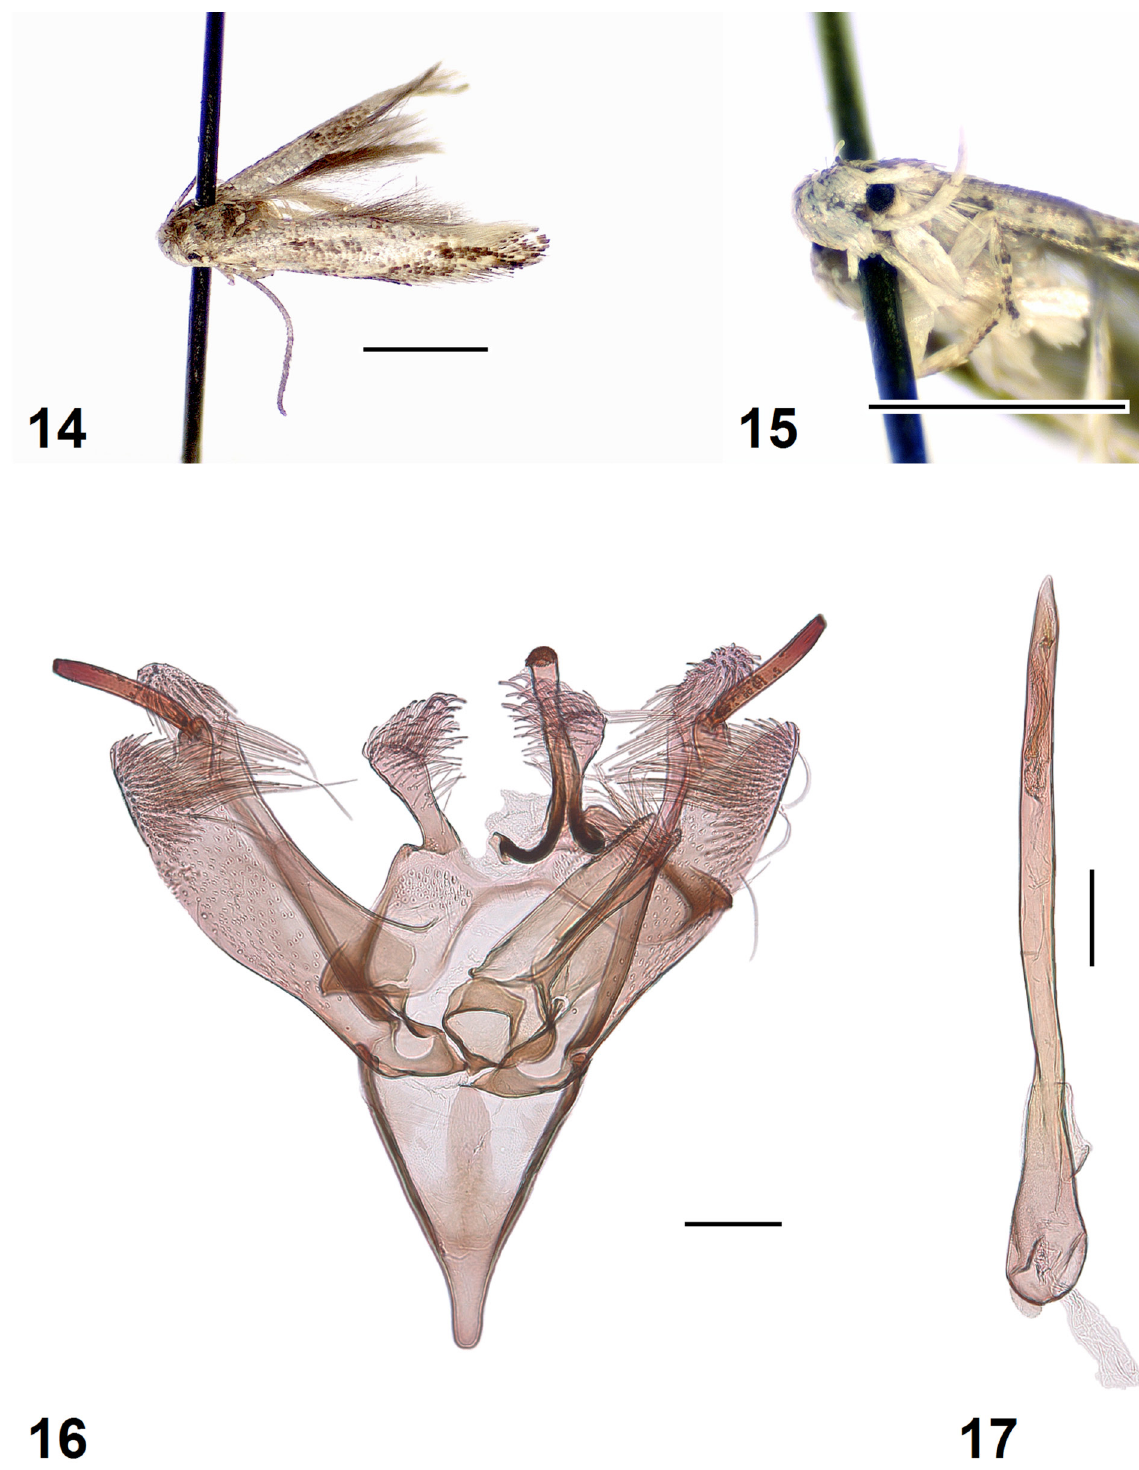
Figs 14–17. Elachista oryx Sruoga & Kaila sp. nov., holotype, ♂ (MZH VS1/23.11.18). 14 . Adult. 15 . Head, latero-frontal view. 16 . General view of male genitalia (phallus removed). 17 . Phallus. Scale bars: 14–15 = 1 mm; 16–17 = 0.1